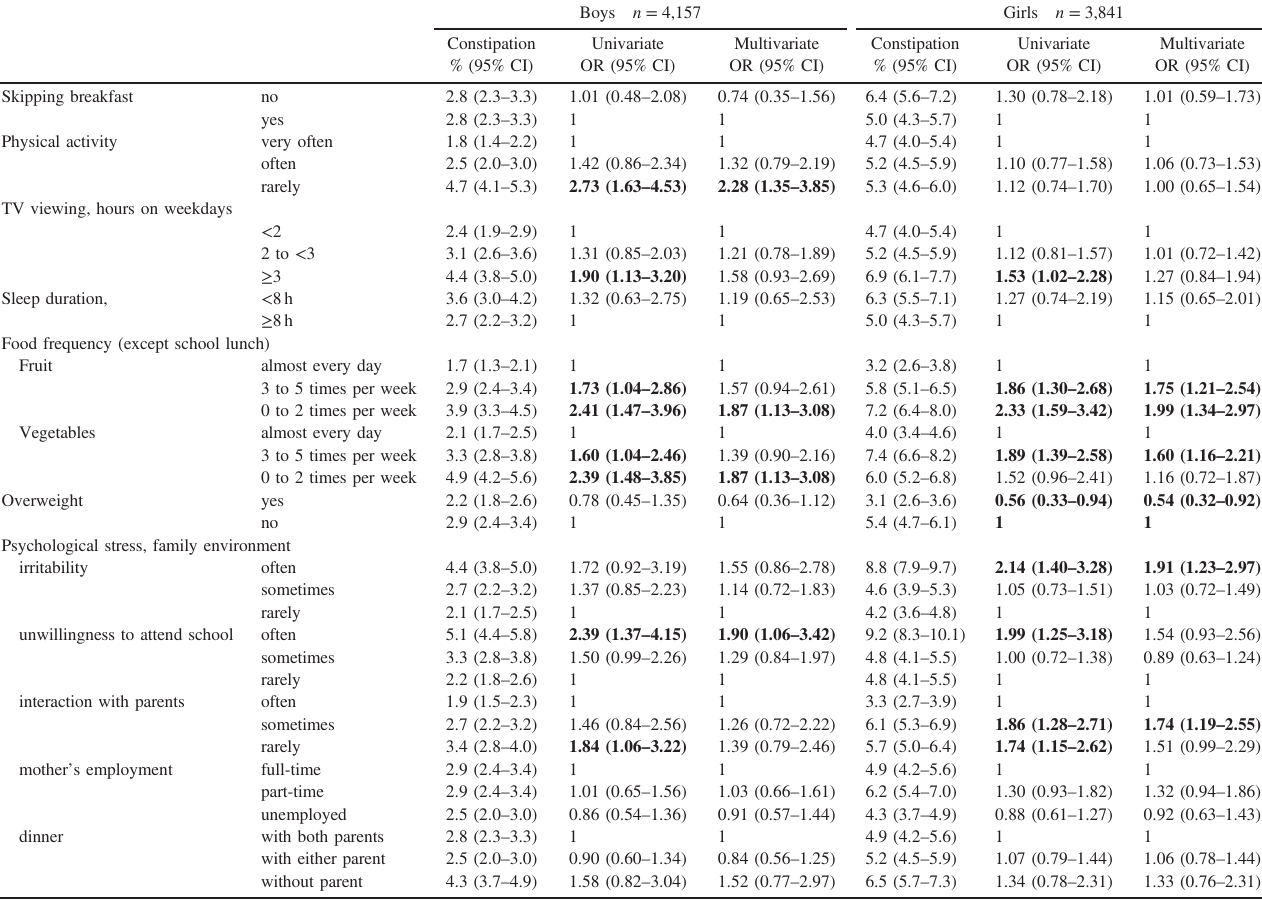
Table 3. Logistic Regression analyses on constipation (less than once every 2 days) by sex Boys n = 4,157 Girls n = 3,841